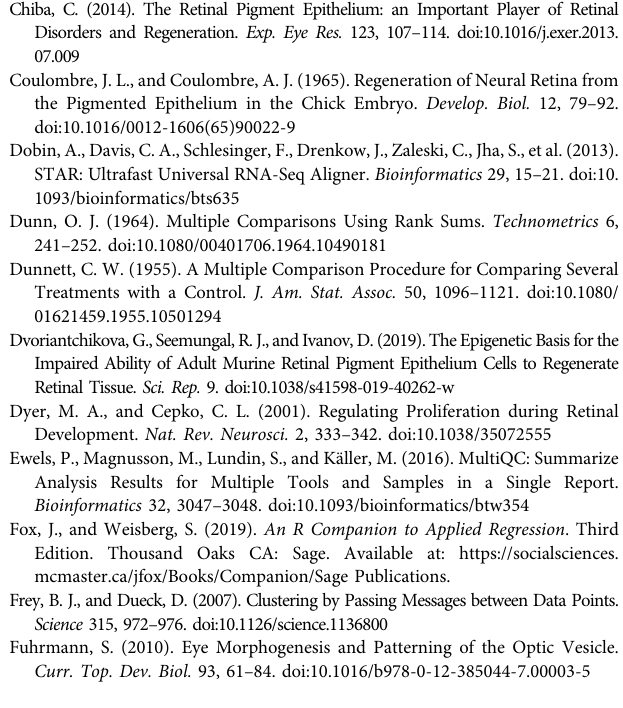
Supplementary Figure 6 | Accessibility and gene expression underscore AP1 factors as a hallmark of the RPE response to retinectomy and FGF2. (A) Gene expression values were binned into quintiles by gene expression (TPM) and the median accessibility signal proximal to transcript start sites (TSSs) were plotted for each bin. (B) DARs were annotated according to their genomic feature distribution. (C) Scatter plot displays the accessibility log fold change (LFC) of peak summit accessibility when comparing intact to 6hPR + FGF2 samples at E4 941 (x-axis) and E5 (y-axis). Only peak summits with adj. p-value ≤ 0.05 are shown. Overrepresented motifs in C were analyzed using the HOMER motif discover tool and top 15 motifs associated with accessibility changes at E4 (D) and E5 (E) are plotted. (F) RNA-seq normalized counts are plotted for JUN and FOS. Asterisk (*) indicates adjusted p. ≤ 0.05. y-axis is log-scaled. Supplementary Figure 7 | Speci fi c transcription factor binding events are associated with differential gene expression. Differentially accessible peak summits were mapped to the nearest gene TSS, and genes with signi fi cant expression changes (adj. p < 0.05) were retained. Changes in accessibility and the accompanying change in gene expression were plotted. The regulatory logic linking differential accessibility to differential expression was inferred based on the quadrant in which each event is plotted (e.g., quadrant I in [A] contains genomic regions of increased E5 accessibility that are explicitly associated with increased E5 gene expression). HOMER motif analysis was used to identify overrepresented transcription factor binding motifs within each quadrant, which are displayed in tables for the developing (A) and 6hPR * FGF2 (B) conditions. Supplementary Figure 8 | Binned motif analysis reveals a diverse set of transcription factors associated with RPE maturation. The monaLisa motif enrichment tool was used with the JASPAR 2022 vertebrate motif database to plot motifs enriched in the E4 or E5 RPE. All motifs with -log(adj. p-value) > 3 in at least 1 peak bin are displayed for intact (A) and 6hPR + FGF2 (B) samples. Supplementary Figure 9 | Binned k-mer analysis overlaps with known transcription factor motifs. The monaLisa motif enrichment tool was used to detect enriched six nucleotide k-mers in the intact (A) or 6hPR + FGF2 (B) peak summits. Enriched k-mers with -log(adj. p-value) > 3 were matched to known motifs in the JASPAR 2022 database and similarity was plotted in the shown